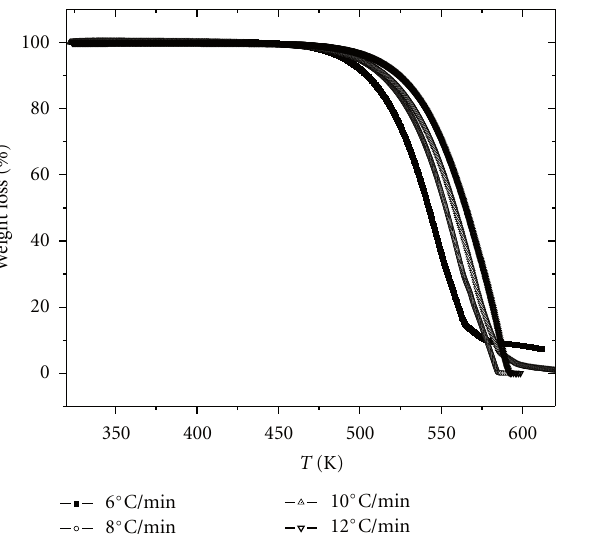
F 1: Nonisothermal TG curve of Zr heating rates.